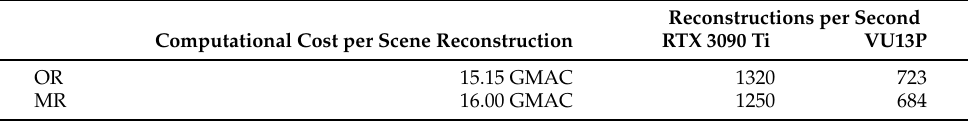
Table 3. Required computing power for one reconstruction and highest reconstruction rate depending on the computing